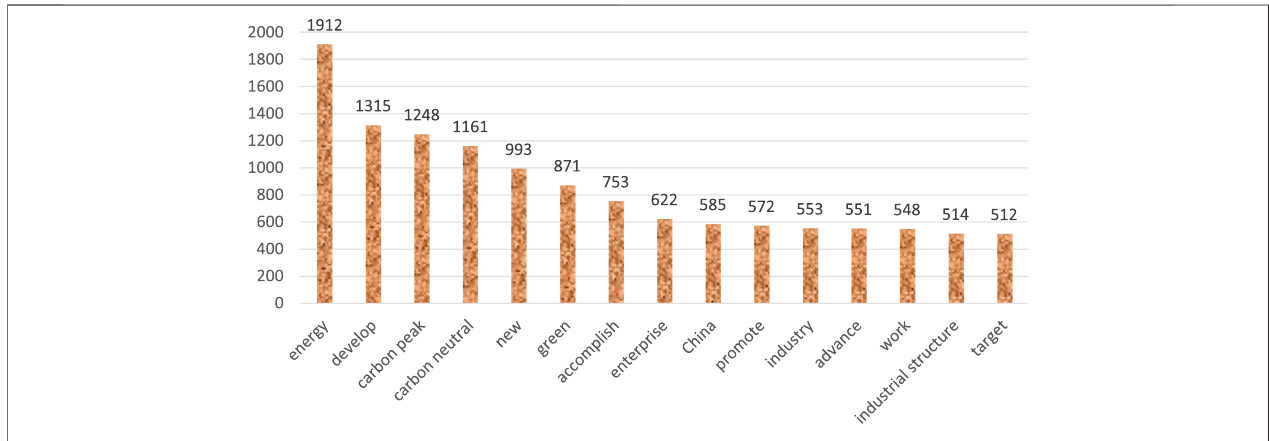
Frontiers in Environmental Science |